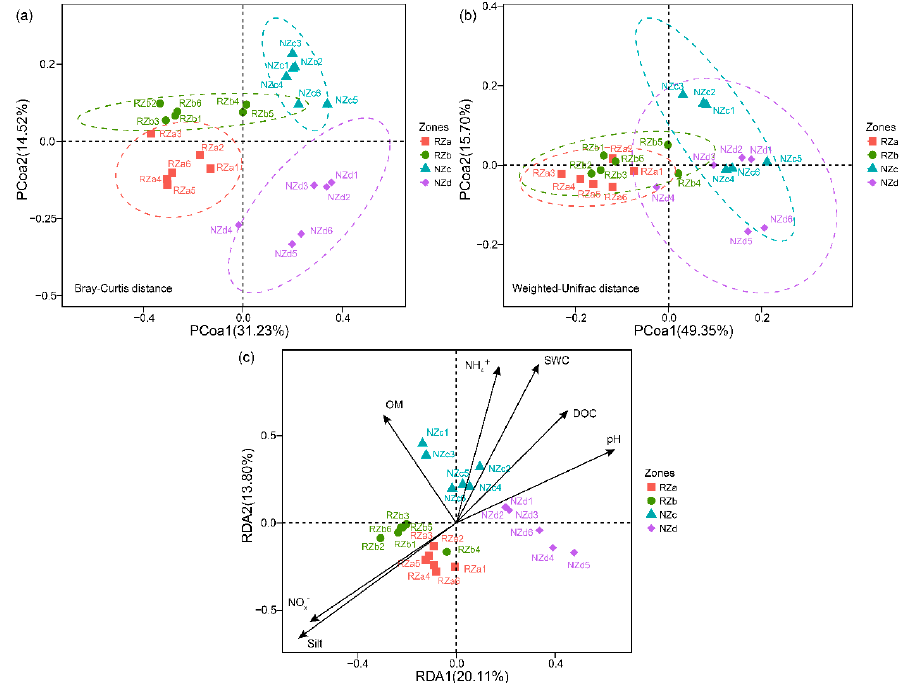
Figure 3. ( a ) Visualizes the output of the linear discriminant analysis effect size (LEfSe)algorithm, which identifies taxonomically consistent among four sites as following: Supralittoral zone with P. australis (RZa), eulittoral zone with P. australis (RZb), eulittoral zone without P. australis (NZc), and infralittoral zone without P. australis (NZd). ( b ) Indicator bacterial groups within the four zones with linear discriminant analysis (LDA) scores higher than 3.